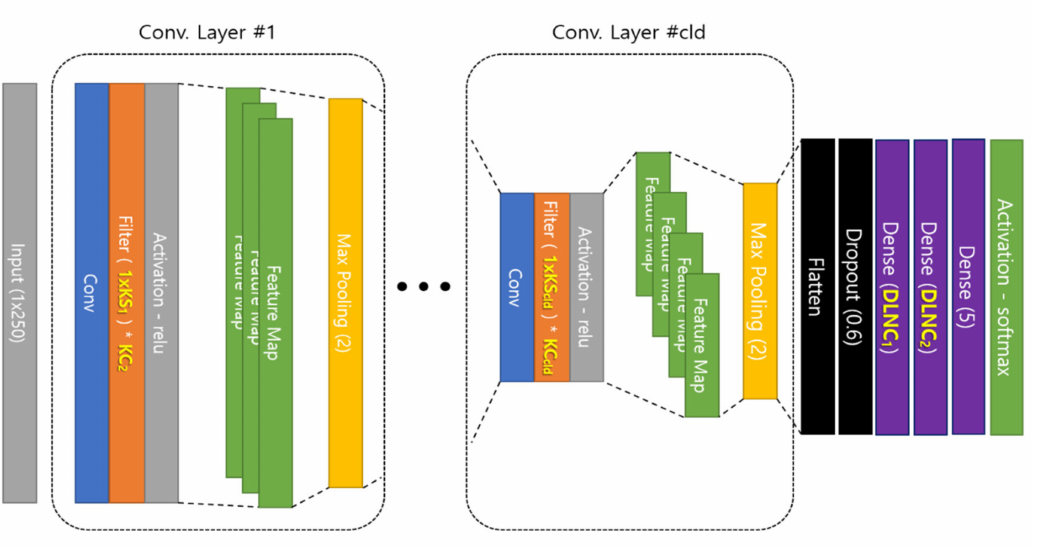
Figure 4. Layout of 1D CNN model used in proposed